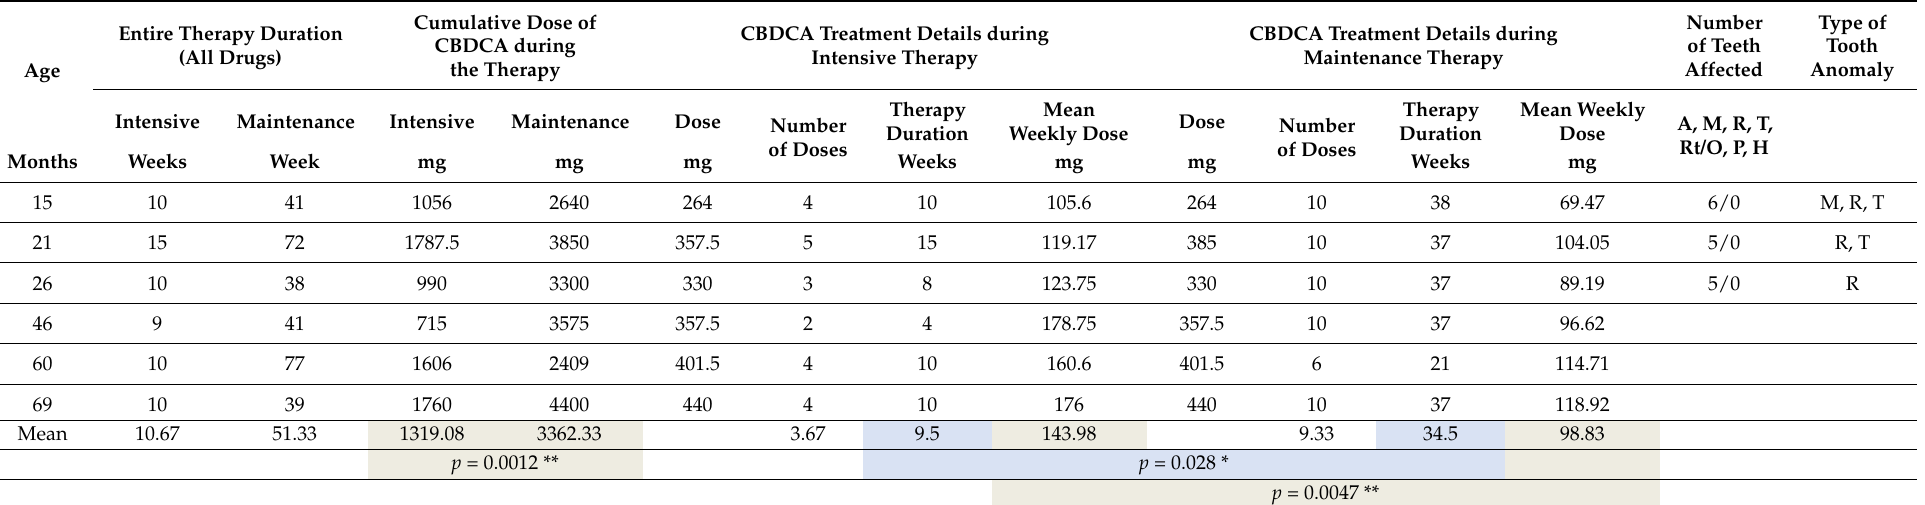
Table 4. Therapy characteristics in patients receiving CBDCA during intensive and maintenance treatment in relation to number of teeth affected and type of